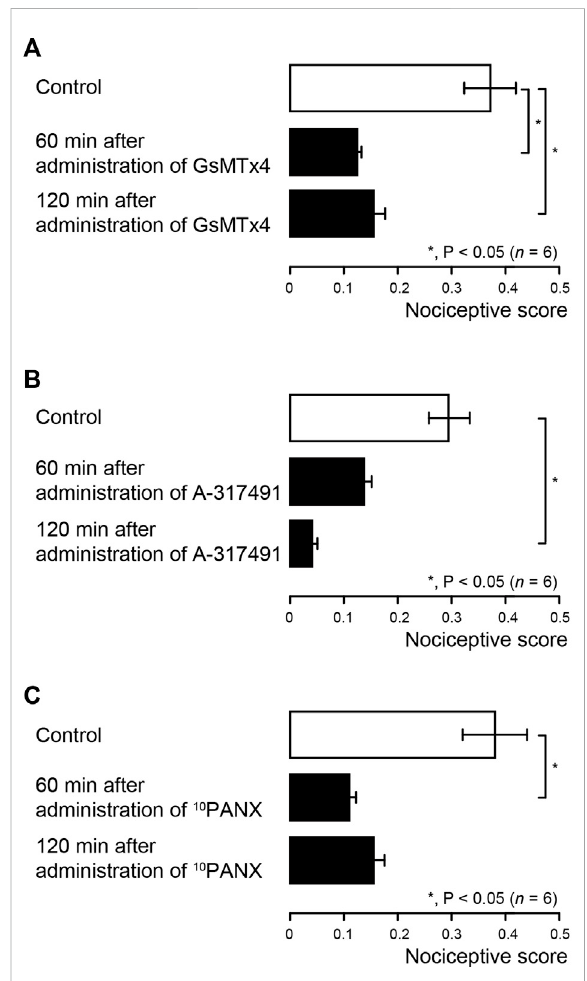
Pharmacological effects of Piezo1 channel (GsMTx-4), PANX-1 ( 10 PANX) and P2X 3 receptor (A-317491) antagonists on dentinal sensitivity in rat fi rst molar (A – C) Bar graphs showing the mean nociceptive scores following cold water (0.1 ml, 4.0 – 7.0 ° C)stimulationtothedentinsurfaceofthelower fi rstmolar in the dentin-exposed group rats without any treatment (control; withecolumns)andtheirvaluestreatedwithGsMTx-4(A; n =6),A- 317491 (B; n = 6), and 10 PANX (C; n = 6) (black columns) 60 min (middle columns) and 120 min (lower columns) after administration of each agent. The cold water stimuli-induced nociceptive scores were measured repeatedly at 60 and 120 min later each (see also Materials and Methods). Each bar represents the mean ± SE of the number of experiments. Asterisks denote signi fi cant differences between columns (shown by solid lines): * p <